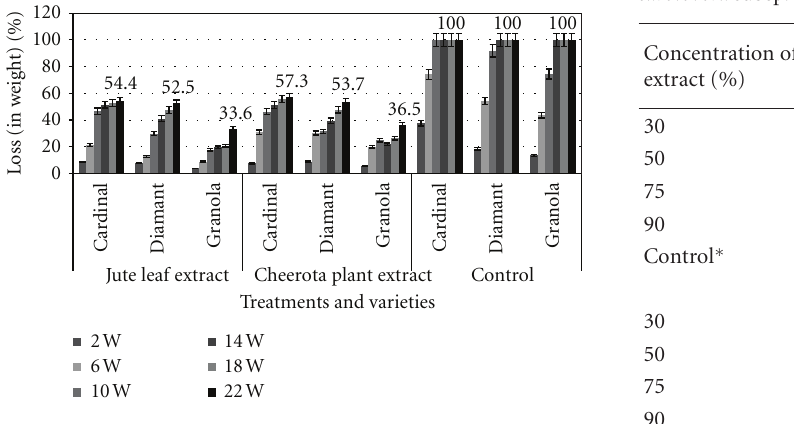
Figure 4: E ff ect of tuber treatment with jute leaf extract and cheerota plant extract on percentage of loss in weight of potato in storage condition.